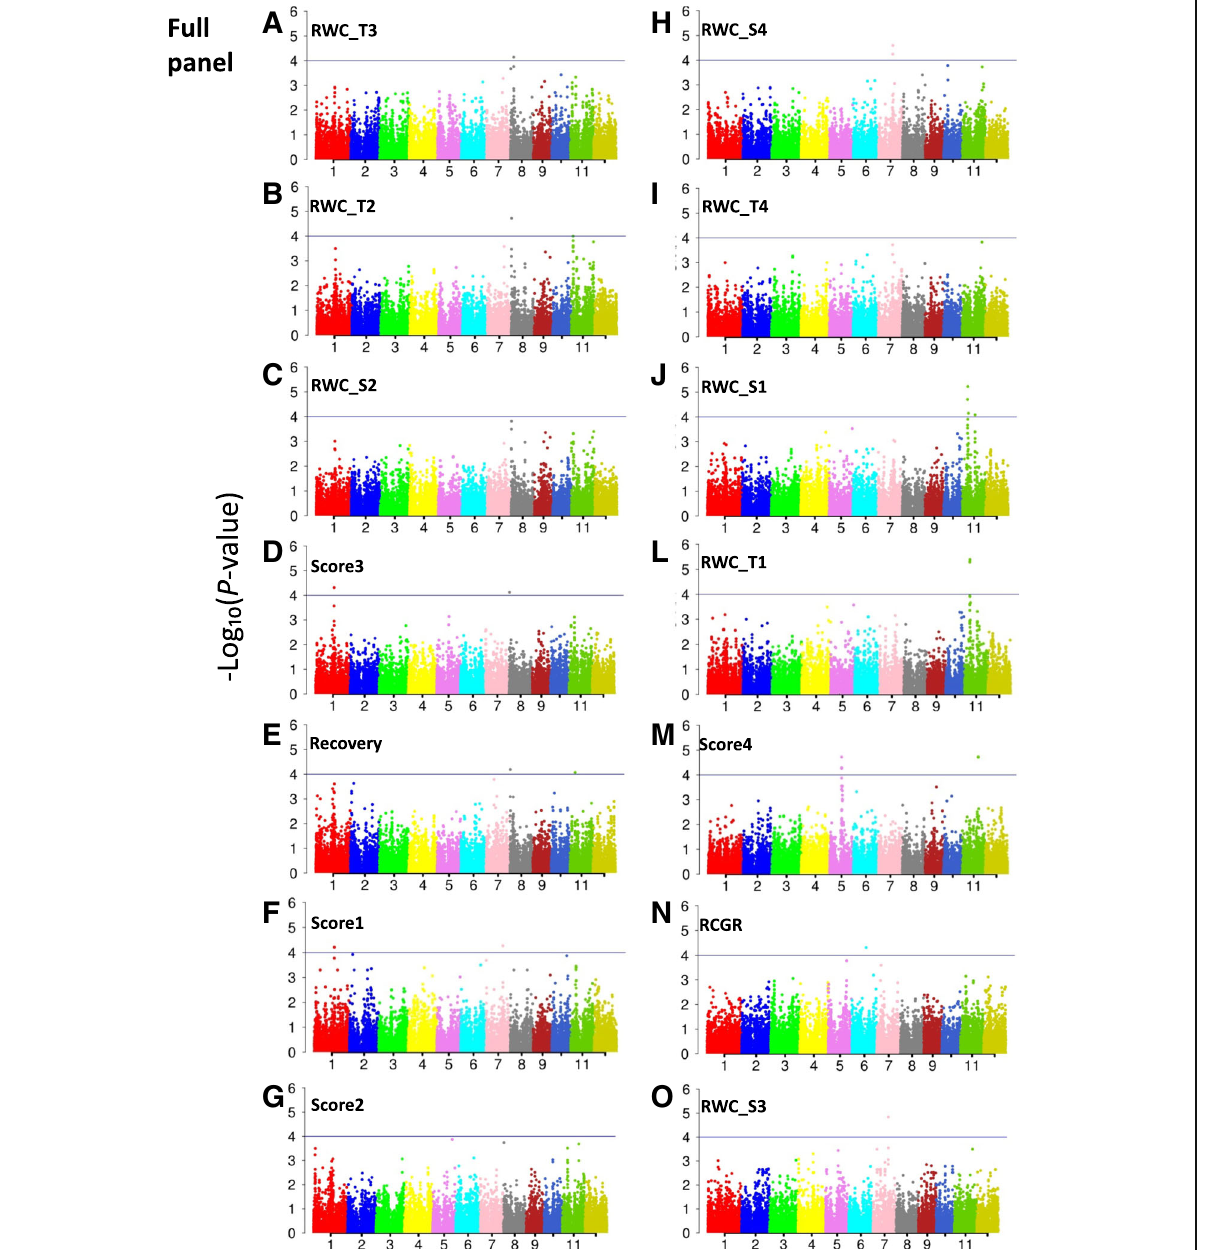
Fig. 5 Manhattan plots for genome-wide association of drought-related traits with SNP markers for the full panel. RWC_T1 to RWC_T4, relative water content after 1 to 4 weeks of drought stress; RWC_S1 to RWC_S4, slope of relative water content after 1 to 4 weeks of drought stress; Score1 to Score4, drought sensitivity score after 1 to 4 weeks of drought stress; Recovery, recovery ability; RCGR, relative crop growth